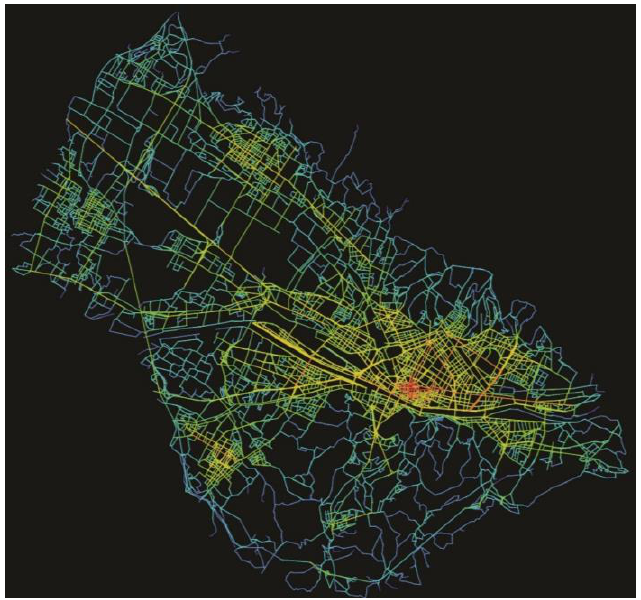
Figure 6. Distribution of local (radius R = 3) integration in the present Florentine conurbation.